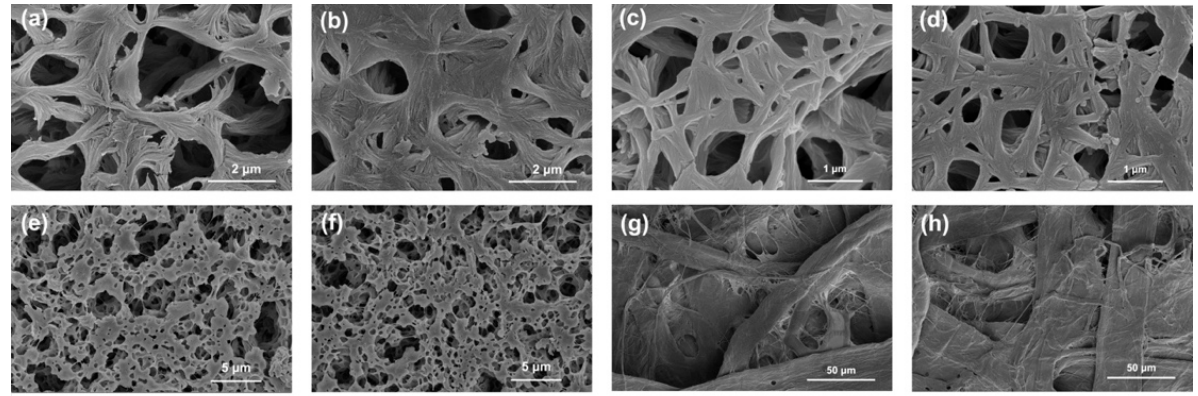
Figure 2. FESEM images of ( a , b ) PA and PA-BWT, ( c , d ) PA-AA and PA-AA-BWT, ( e , f ) PVDF and PVDF-BWT, and ( g , h ) CELL and CELL-BWT.